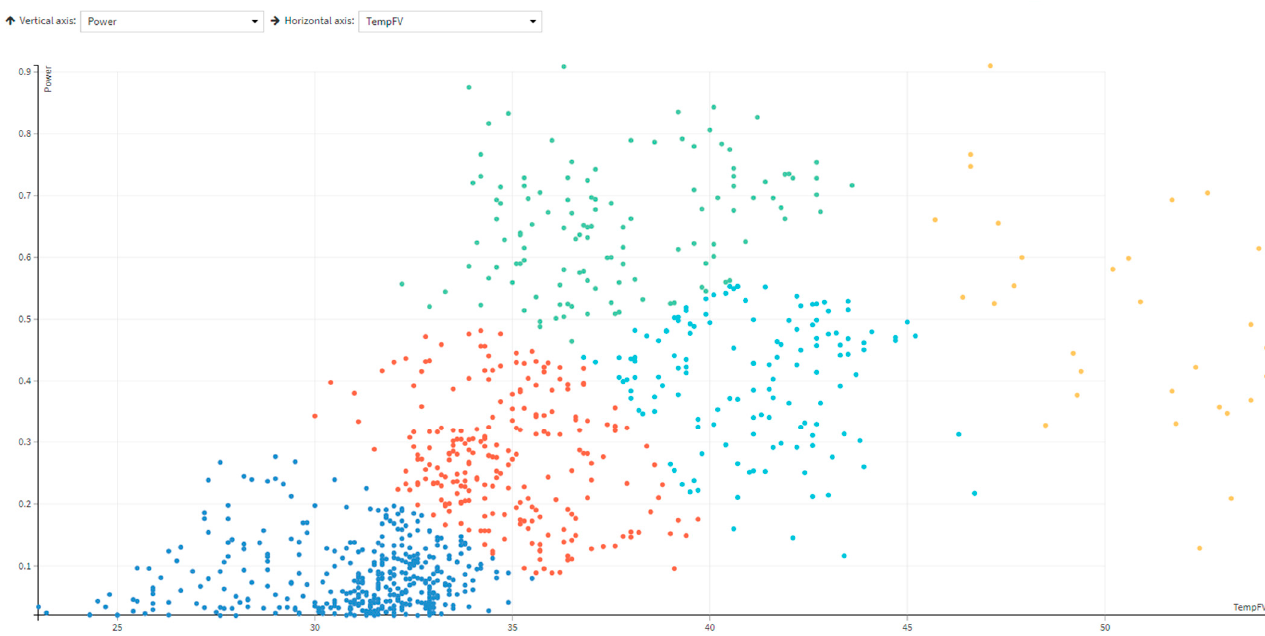
Figure 6. Data group scatter plot (KMeans 5).